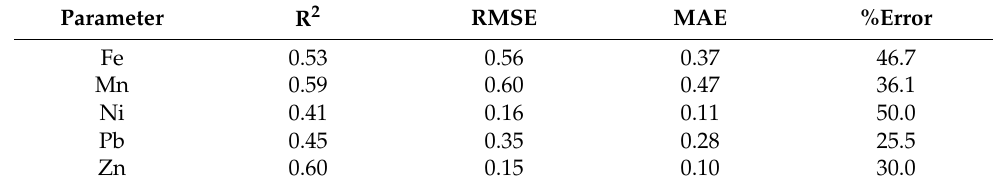
Table 3. Validation results for soil heavy metals (mg/kg − 1 ) predicted using the RF